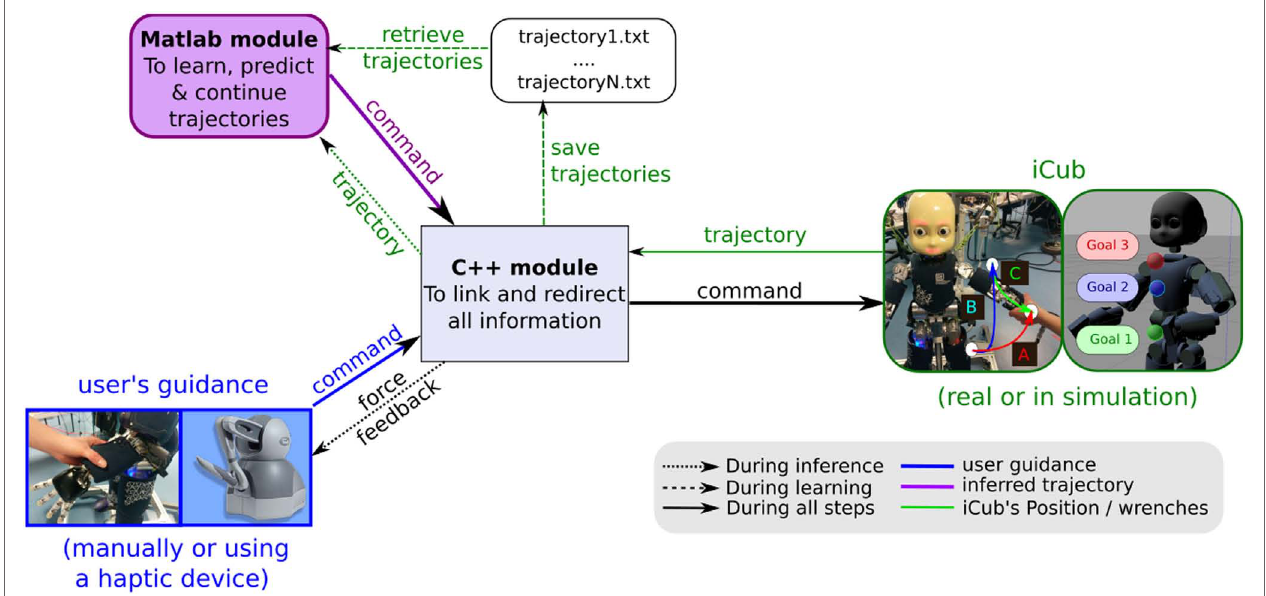
FIGURE 5 | Software architecture and data flows. The robot’s control is done either by the user’s guidance (manually or through a haptic device) represented in blue, or by the Matlab module, in purple. The C ++ module handles the control source to command the robot, as represented in black. Moreover, this module forwards information that comes from the